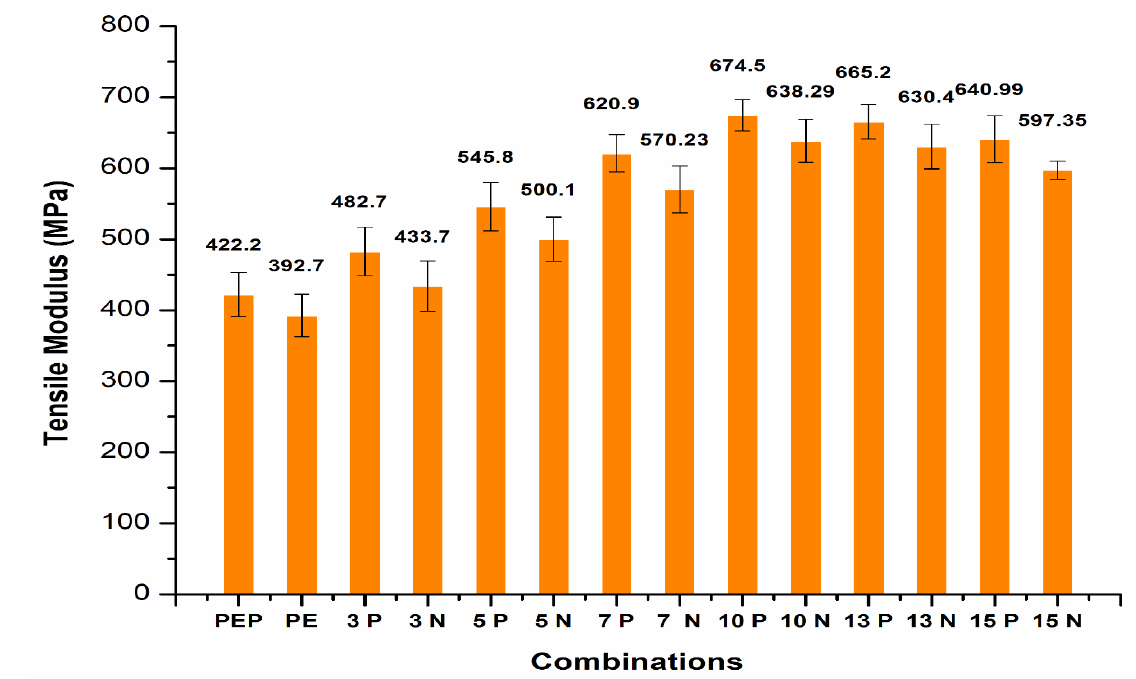
Figure 10. Tensile modulus of CF/PE composites.